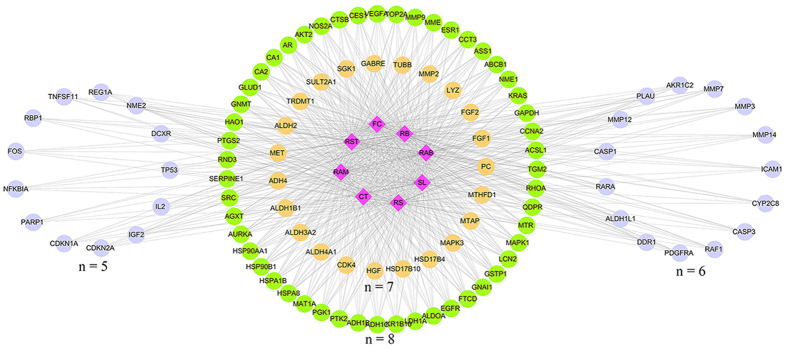
The herb-target networks of the 8 herbs.The diamond nodes represent herbs, and the circular nodes represent targets. The targets distributed in a circle represent they are acting by the same number of herbs, which illustrated as “n”.